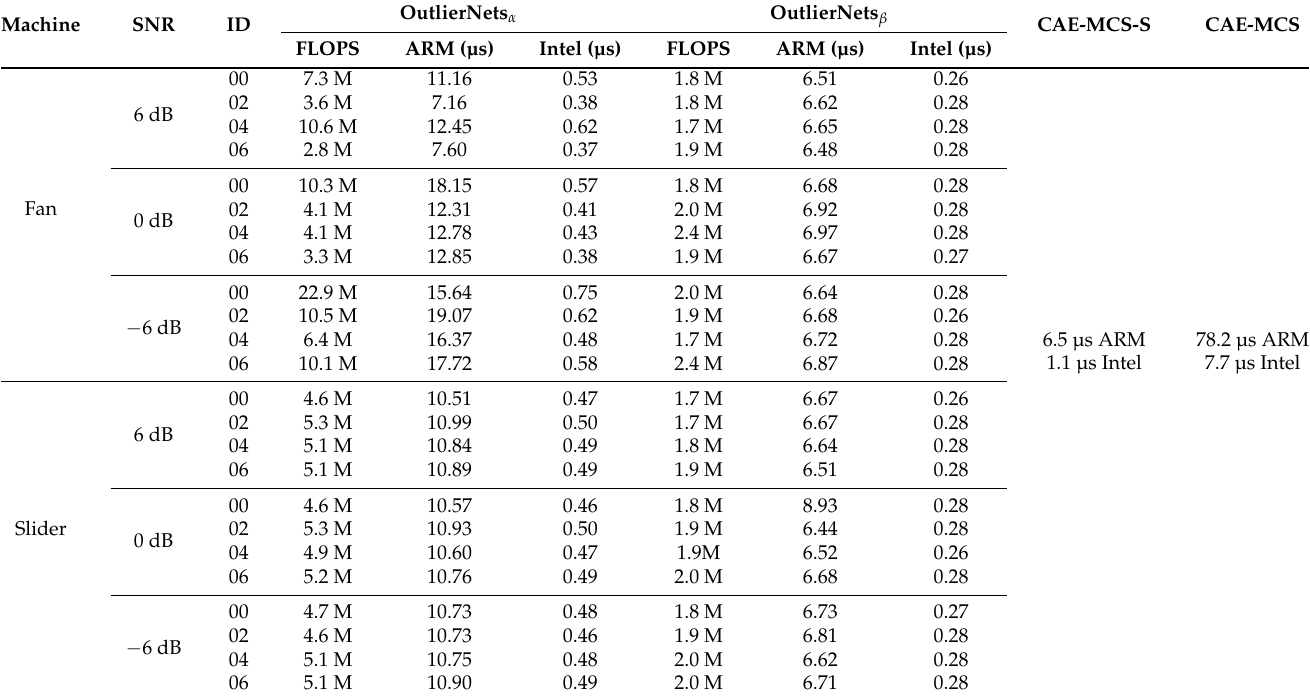
Table 2. Efficiency comparison between OutlierNet architectures with the convolutional autoencoder architecture in [2] in terms of FLOPS and on-device latency with an ARM Cortex-A72 embedded CPU and an Intel Core i5-7600K desktop CPU. These measurements are included in the columns ARM ( µ s) and Intel ( µ s)